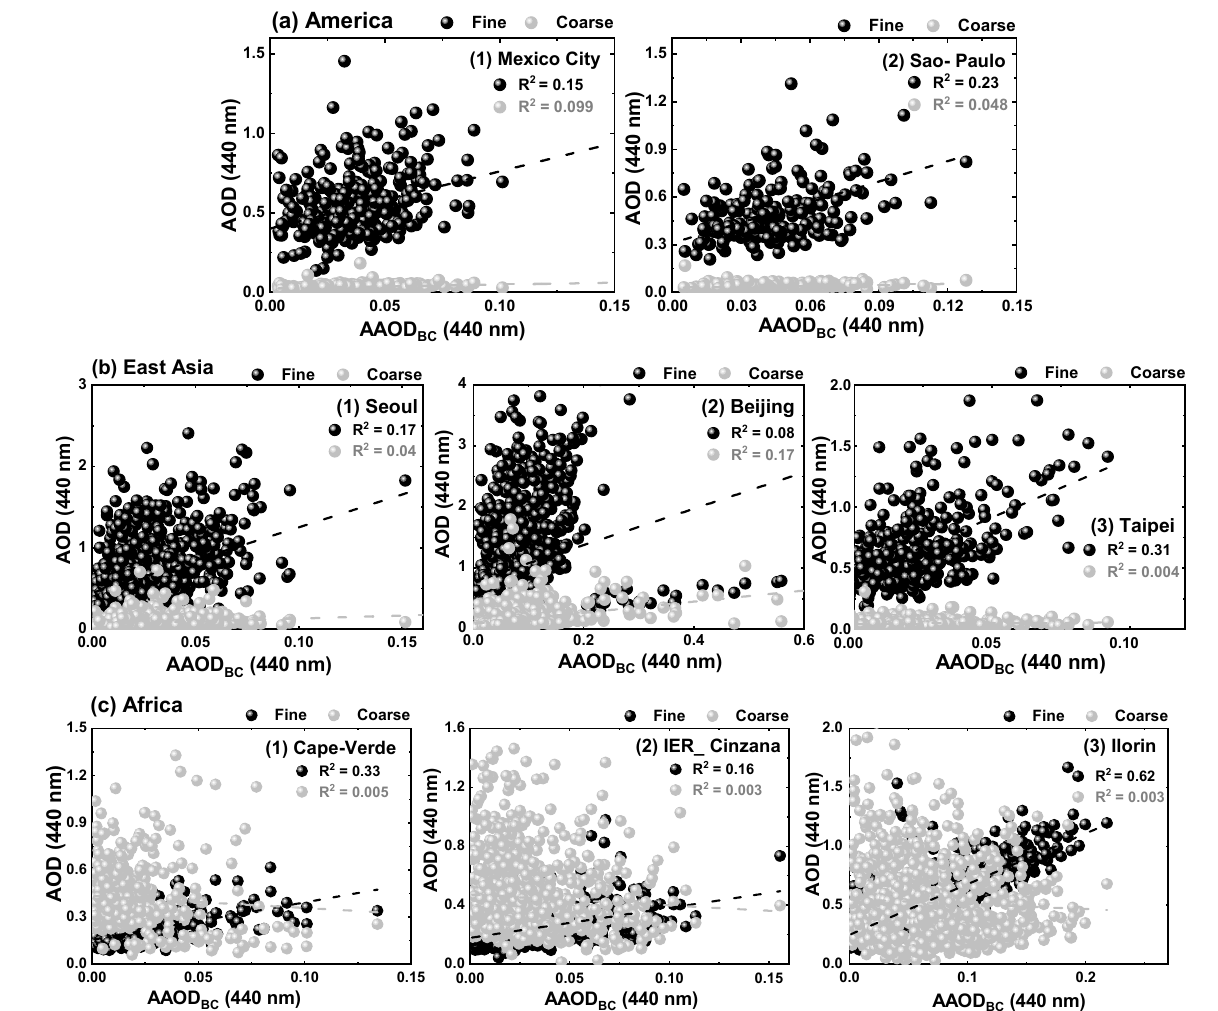
Figure 7. The coefficient of determination (R 2 ) between AAOD BC and AOD T at 440 nm for the fine mode (black circles) and the coarse mode (gray circles) at ( a ) the American, ( b ) East Asian, and ( c ) African sites from 2000 to 2018. The scatterplots of AOD T and AAOD BC at 440 nm for the fine- and coarse mode particles over Europe, the Middle East, and India are plotted in Figure 8. A higher coefficient of determination was observed between AOD T and AAOD BC for the fine mode particles at all the European, Middle Eastern, and Indian sites. The values are 0.031, 0.10, 0.12, 0.13, 0.47, and 0.27 for the fine mode over Thessaloniki, Venice, Mezaira, Solar-Village, Kanpur, and Gandhi-College, respectively. Similar to Mexico City, R 2 indicated smaller values for both the fine- and coarse mode particles over Thessaloniki; nevertheless, a higher correlation was found for fine mode particles over this site as well. AAOD BC exhibited the highest correlation with fine mode particles over Kanpur (R 2 = 0.47); also, higher dependence on fine mode particles was identified over Gandhi Collage (R 2 = 0.27) compared to the other sites.